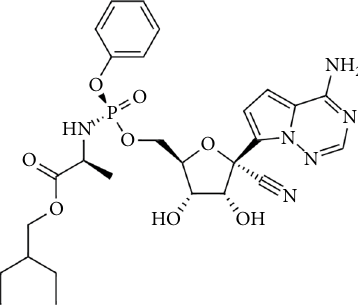
Figure 3: Molecular graph of Remdesivir